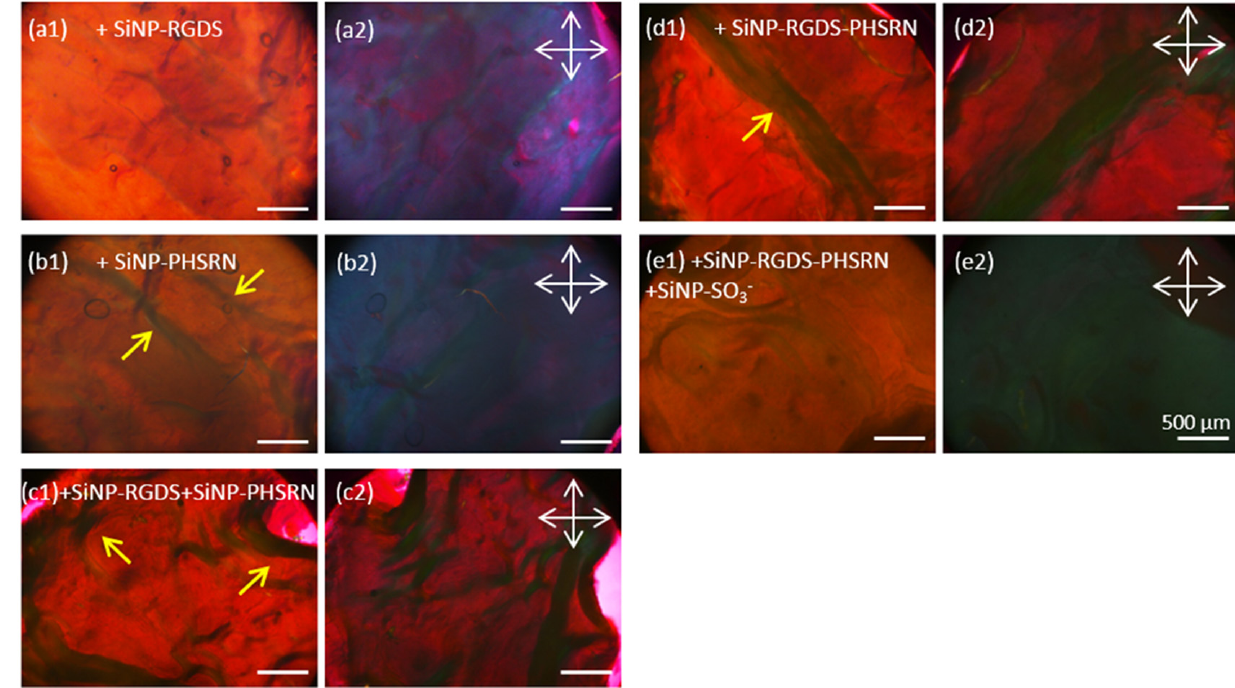
Figure 5. PLM photos of composites made of collagen combined with ( a ) SiNP-RGDS, ( b ) SiNP-PHSRN, ( c ) SiNP-RGDS + SiNP-PHSRN, ( d ) SiNP-RGDS-PHSRN and ( e ) SiNP-RGDS-PHSRN + SiNP-SO 3 − after EDC crosslinking. ( 1 ) and ( 2 ) stand for PLM imaging was performed by taking 2 serial images with the sample oriented vs. the cross polarizers (white arrows) at maximal transmission ( 1 ) and at extinction ( 2 ). Yellow arrows show the presence of millimetric fibrils. A waveplate was added to improve